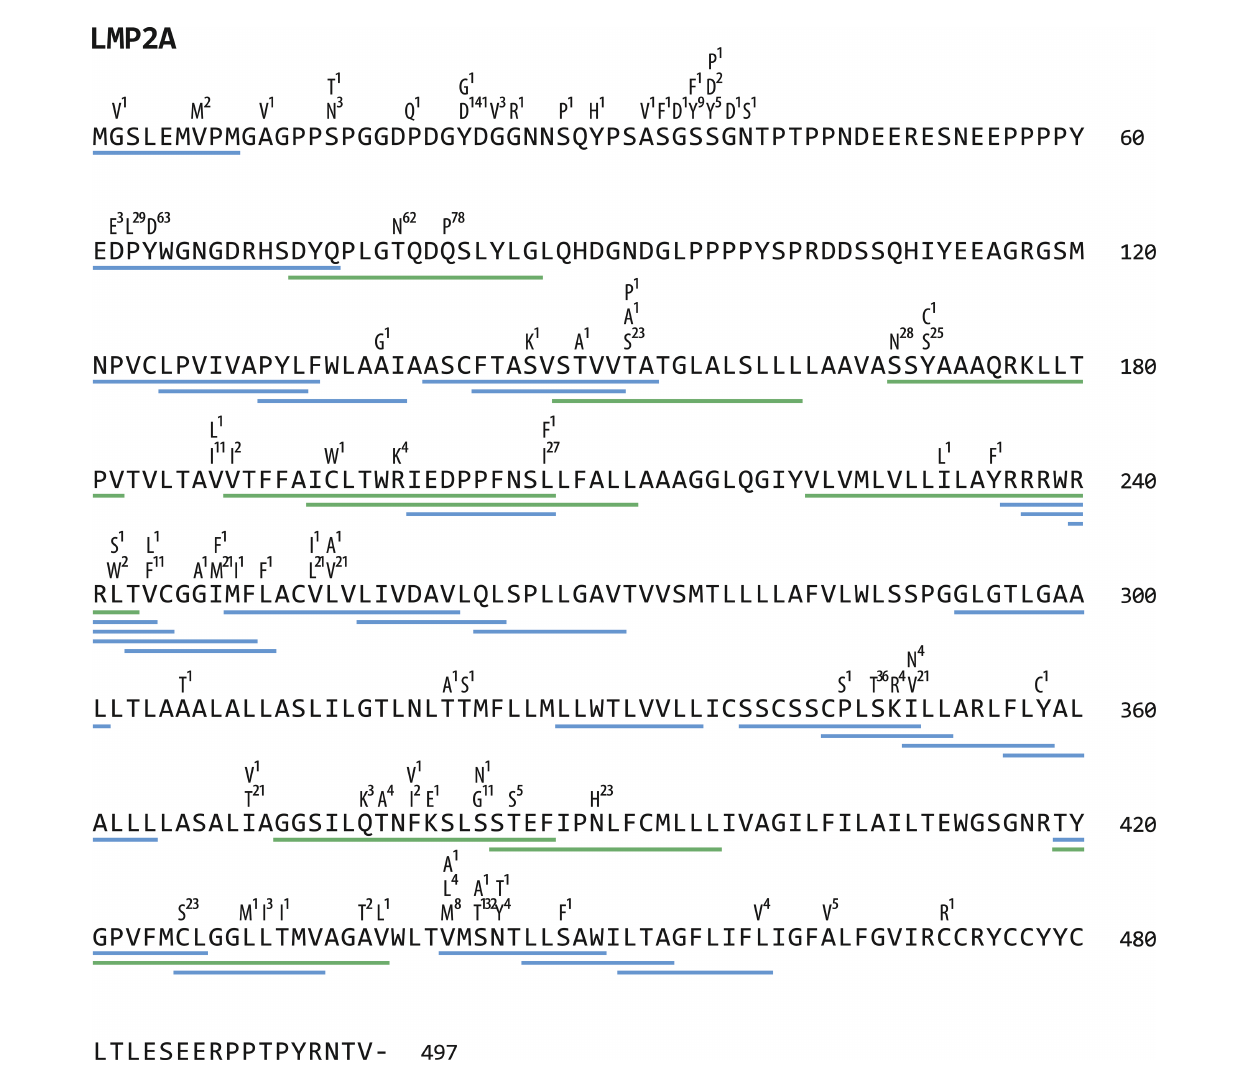
FIGURE 4 | Location of polymorphisms and T-cell epitopes in LMP2A. LMP2A protein sequences of 155 viral strains were aligned and polymorphisms identi fi ed using Clustal Omega software (https://www.ebi.ac.uk/Tools/msa/clustalo/). All identi fi ed amino acid exchanges and the number of strains in which they occurred are displayed above the LMP2A reference sequence from B95.8. Underneath the sequence, green (CD4+) and blue (CD8+) lines indicate the location of T-cell epitopes (further details can be found in Table S3